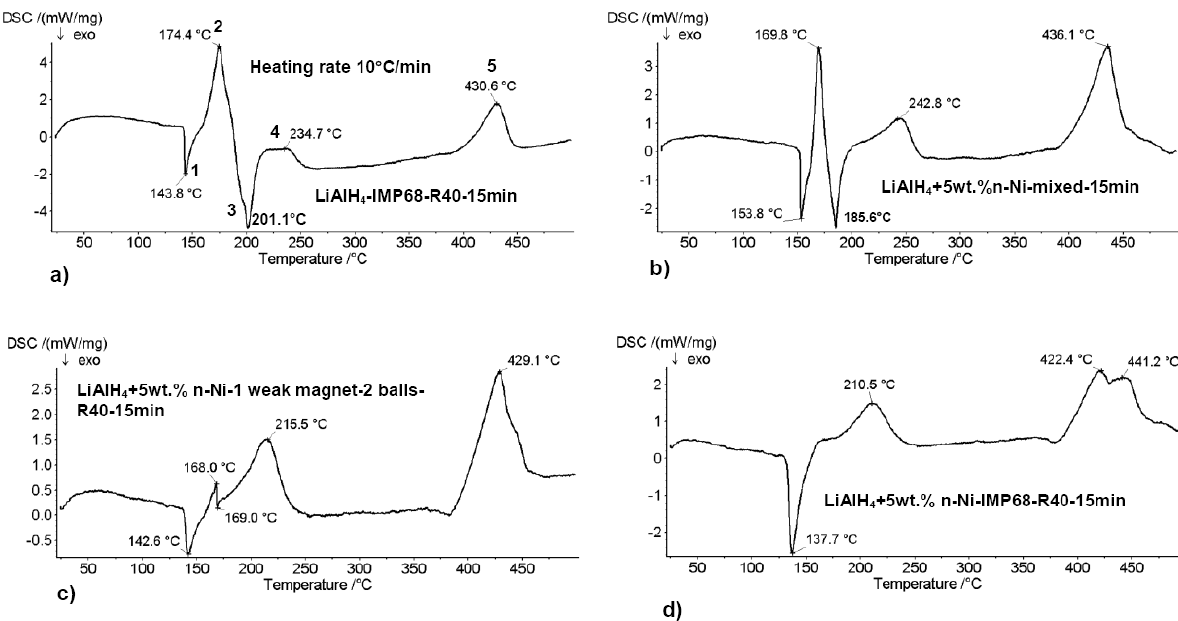
Figure 12. DSC curves for (a) undoped LiAlH milled for 15 min, (b) LiAlH + 5wt.% 4 4 n-Ni mixed, (c) LiAlH + 5wt.% n-Ni milled for 15 min under low energy shearing mode 4 with 1 weak magnet, 2 balls, (d) LiAlH + 5wt.% n-Ni milled for 15 min under high energy 4 milling mode. Heating rate was 10 °C/min. R-ball-to-powder weight ratio; IMP68-high energy impact mode with 2 magnets in a magneto-mill. Adapted from